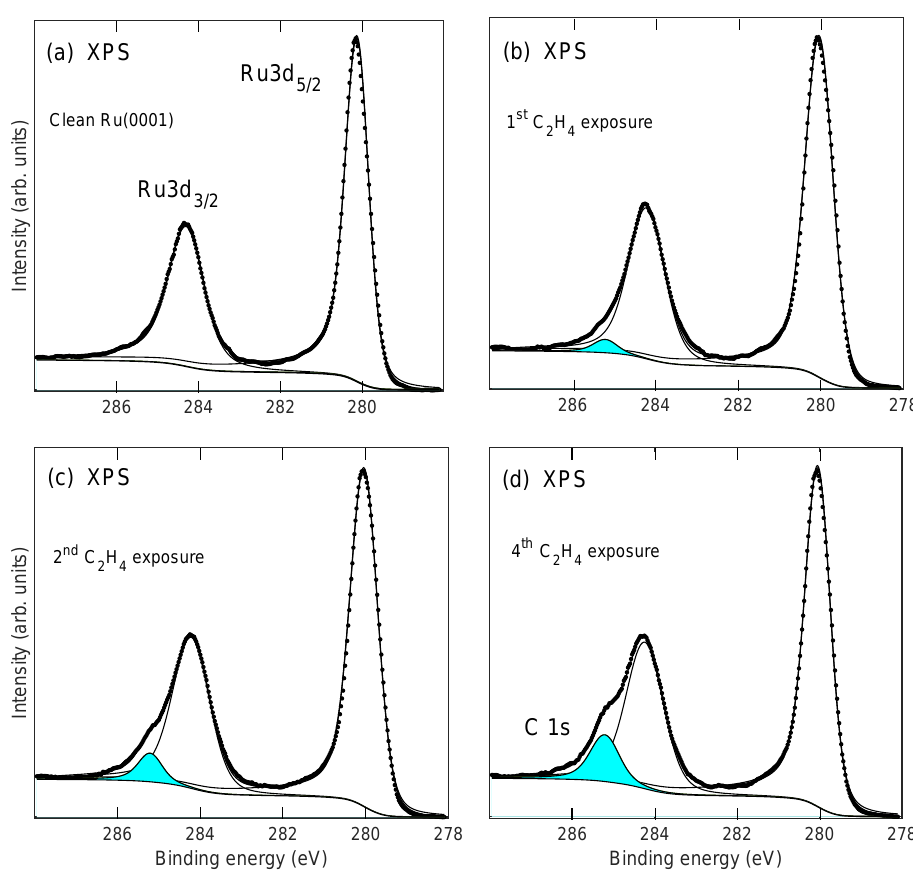
Figure 2. Ru3d 5/2 , Ru3d 3/2 , and C1s XPS after multiple ethylene exposure cycles to Ru(0001): Panels ( a – d ) show spectra recorded for clean Ru(0001) and after first, second, and fourth exposure cycle, respectively (see text). Solid lines show deconvoluted spectra. The filled peak near-binding energy 285.2 eV in each panel is identified as C 1s emission. The electron emission angle with respect to the surface normal was set at 70 ◦ to enhance the surface